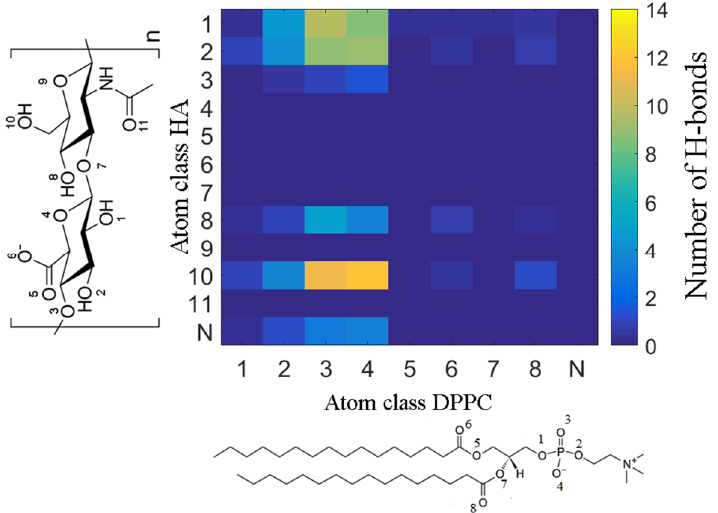
Figure 9. Map showing the number of HA-phospholipid H-bonds between different atom classes in HA. In the graph, HA ( y -axis) and DPPC ( x -axis) in NaCl solution at 37 °C are shown. The color scale indicates the number of H-bonds.